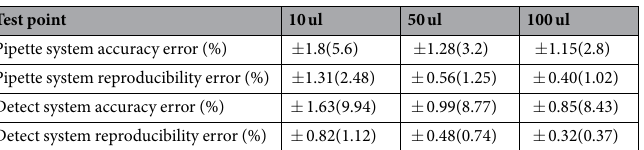
Table 2. System accuracy and repeatability error. (Hint: The data statistics format is: after calibration (before